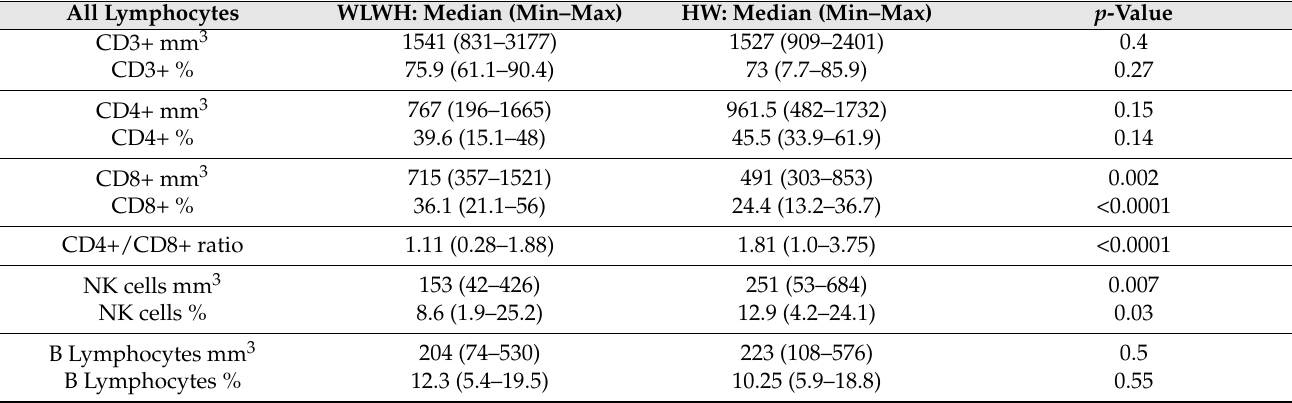
Table 2. Immune cells in WLWH and